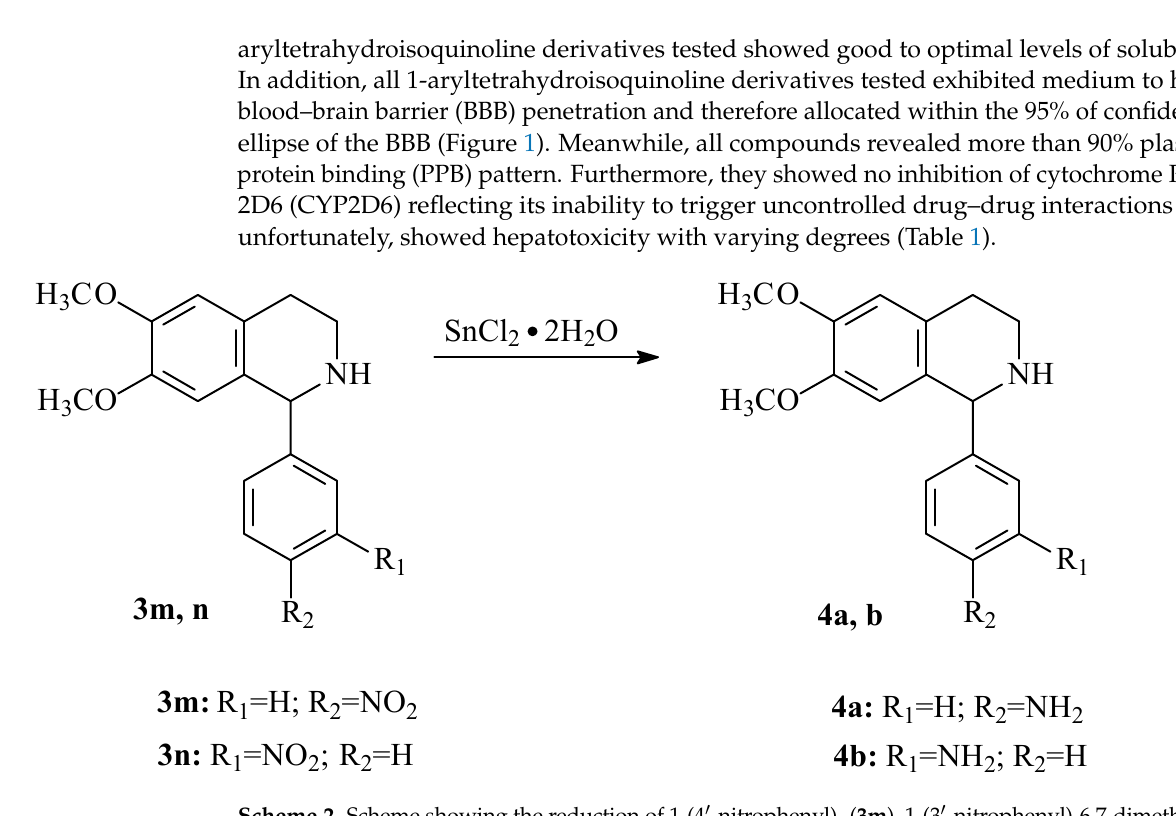
Scheme 2. Scheme showing the reduction of 1-(4 ′ -nitrophenyl)- ( 3m ), 1-(3 ′ -nitrophenyl)-6,7-di- methoxy-1,2,3,4-tetrahydroisoquinolines ( 3n ) to form 4a and 4b. Table 1. ADMET characteristics of the series of synthesized 1-aryltetrahydroisoquinoline